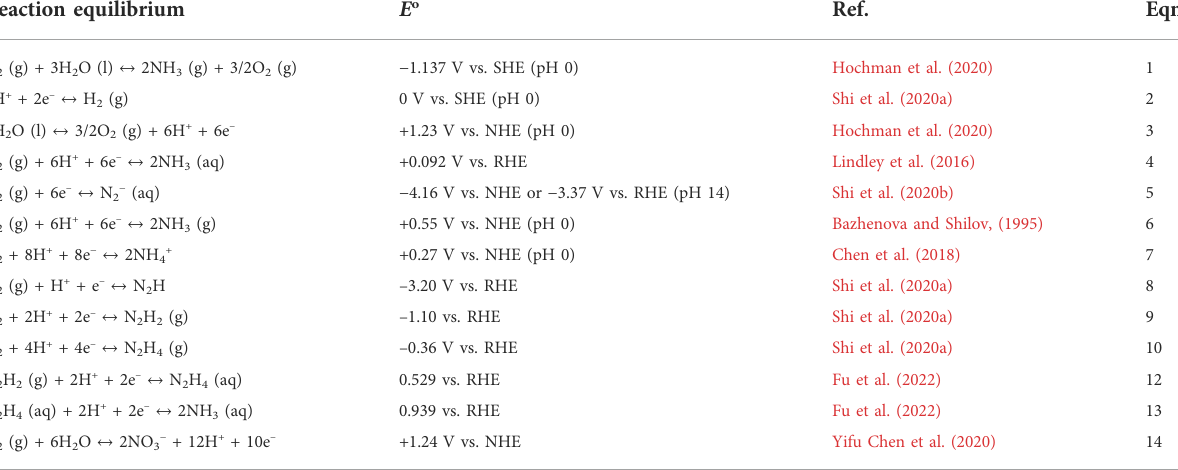
TABLE 1 Thermodynamic potentials of hydrogenation reactions related to the whole nitrogen fi xation pathways. Reaction equilibrium E o Ref.